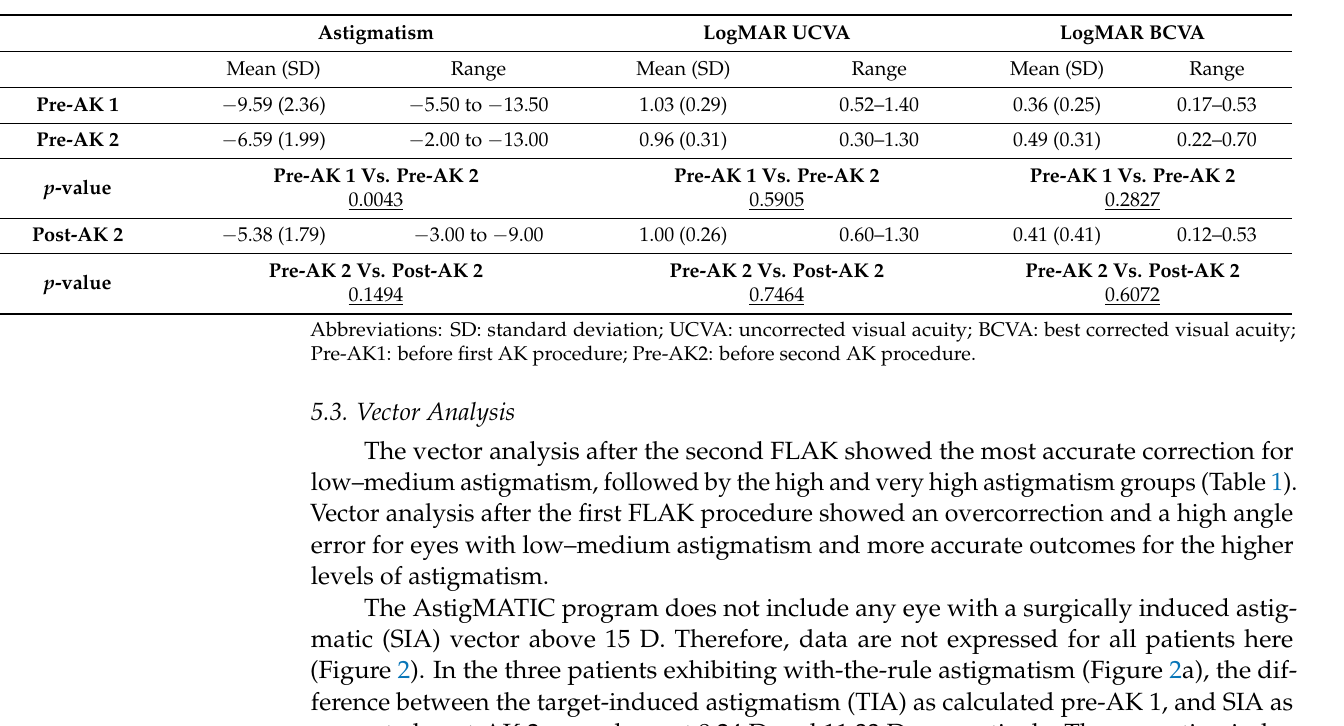
Table 2. Astigmatism and visual acuity values before and after the two Femtosecond laser-assisted astigmatic keratotomy (FLAK) procedures.